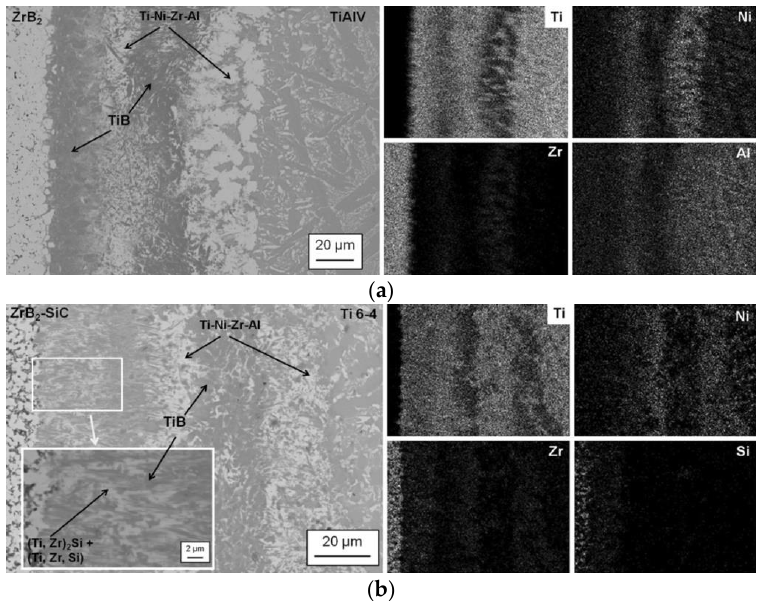
Figure 13. SEM images and EDS elemental maps distribution images of ( a ) Ti6Al4V/NiB50/ZrB 2 and ( b ) Ti6Al4V/NiB50/ZrB 2 -SiC joints, reproduced from Reference [37] with permission of Springer, 2014.